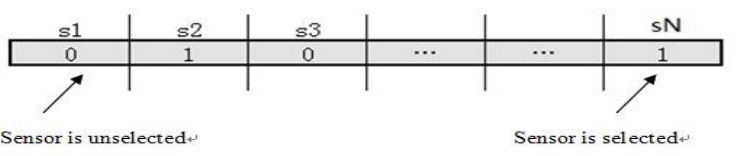
Figure 1. Solution representation in LACRO.